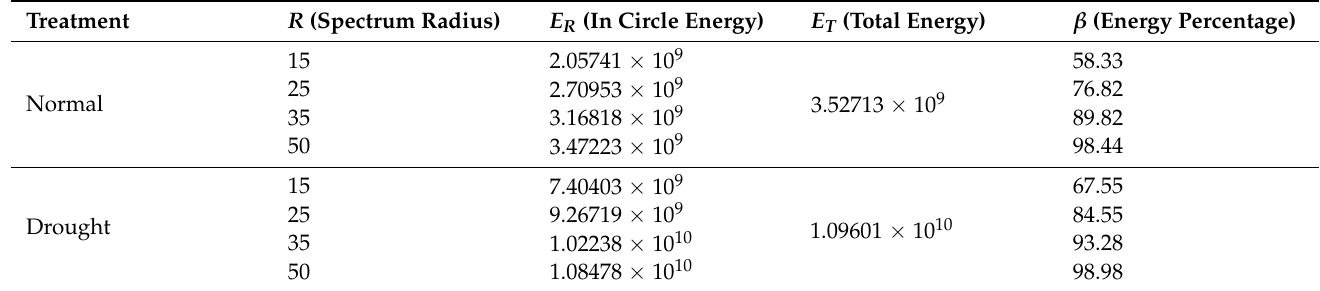
Table 6. Spectrum energy distribution of the soybean canopy in the red channel.